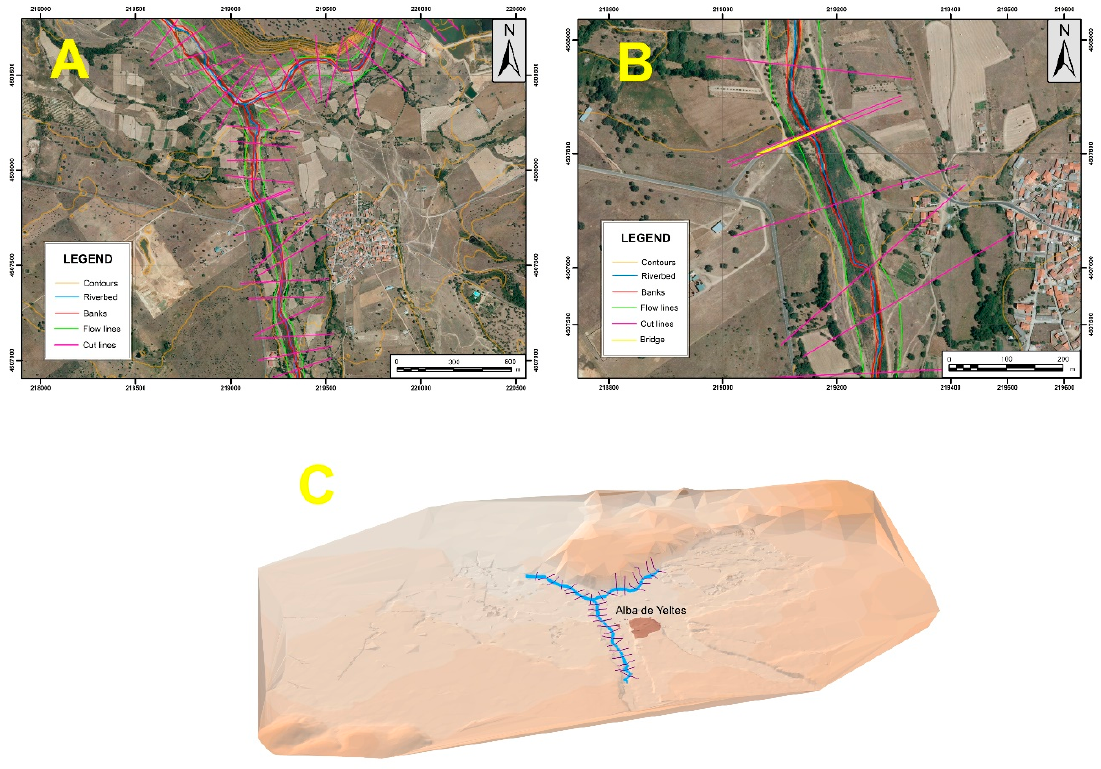
Figure 5. Digitalization of ( A ) the transversal sections ( B ) of the bridge and ( C ) the 3D view of the transversal sections using ArcScene.